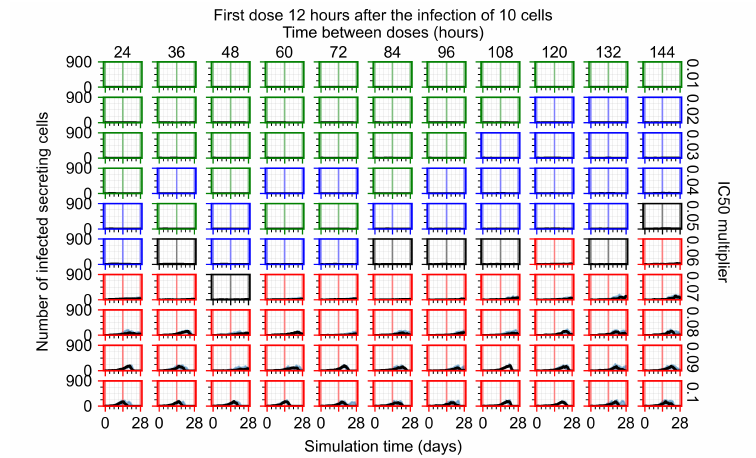
Figure A86. Infected (secreting extracellular virus) population.